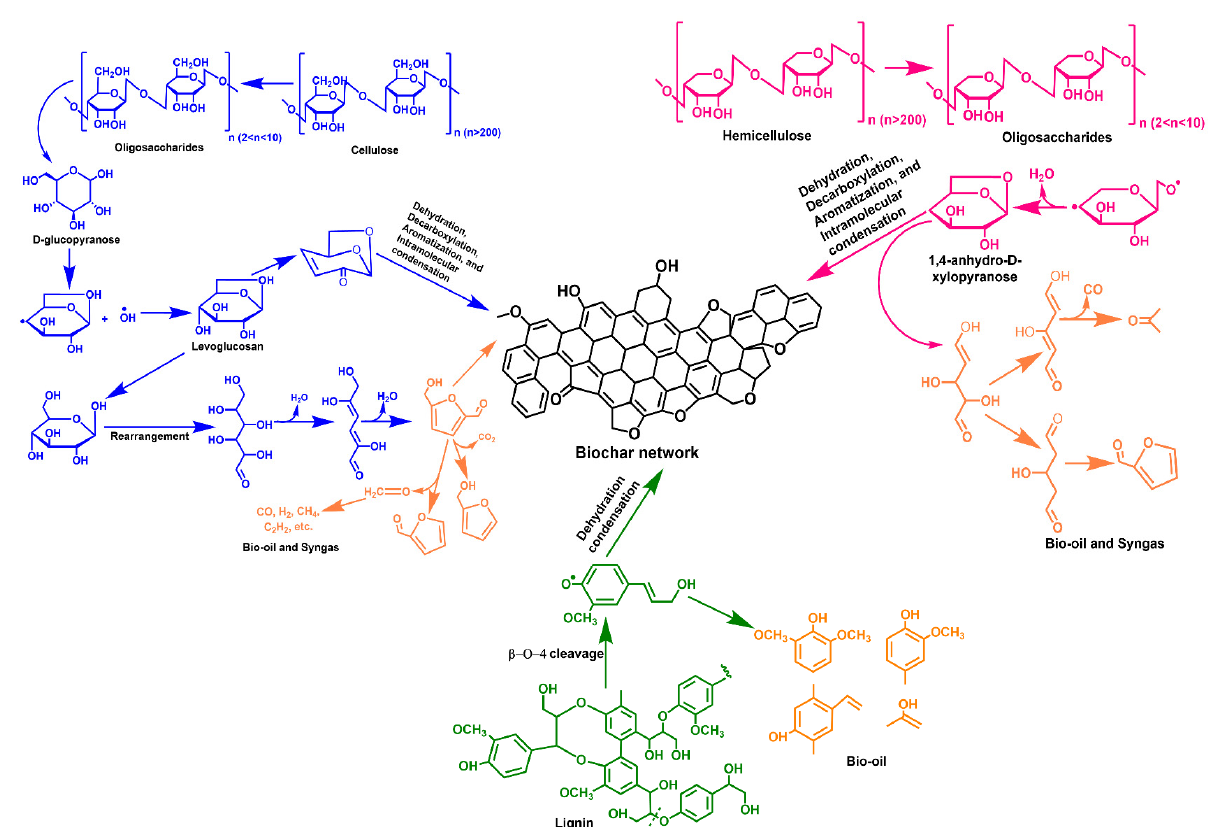
Figure 2. Mechanism of biochar formation from cellulose, hemicellulose, and lignin.Here,